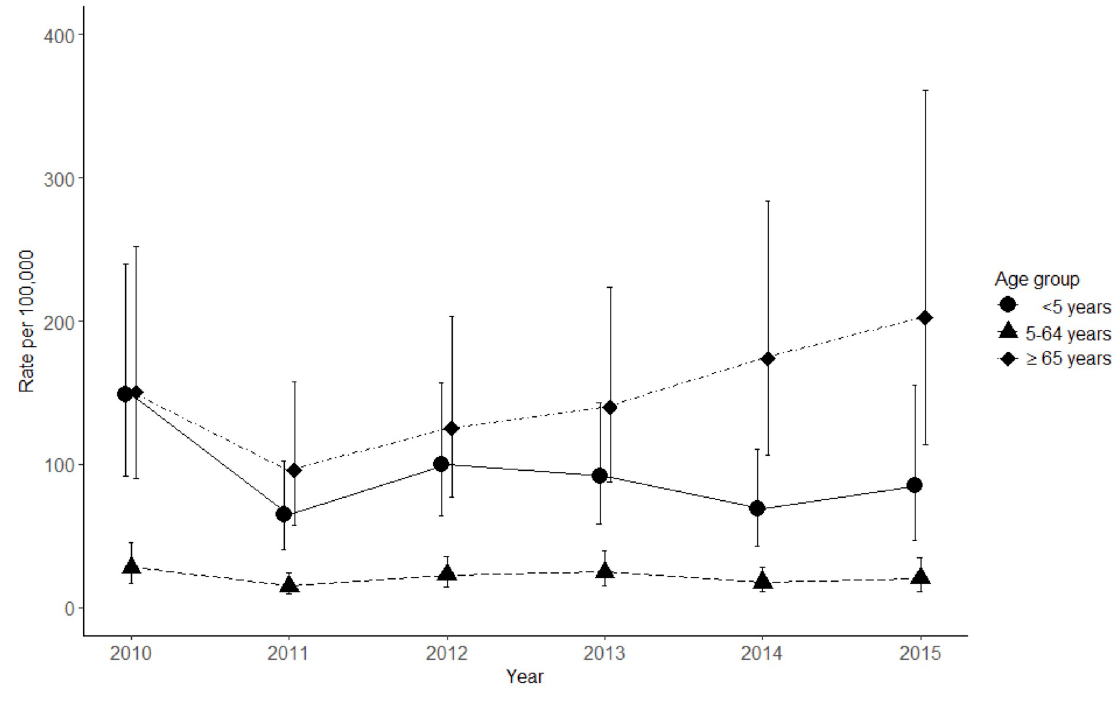
Fig 1. Pooled estimates of influenza-associated hospitalization rates per 100,00 people by year and age group, 2010–2015.